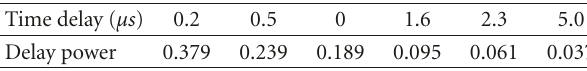
Table 1: COST207 typical urban six-ray power delay profile.